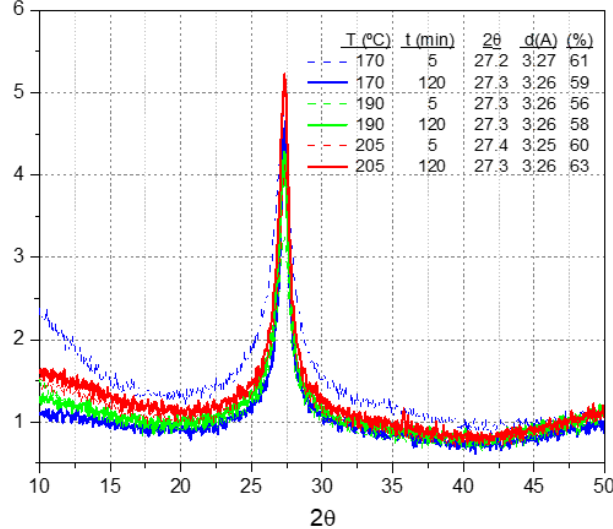
Figure 9. XRD patterns of NH 4 CN polymers synthesized at the temperatures and reaction times indicated, using MWR and water as solvent; d = interplanar distance; (%) = crystallinity of the sample.